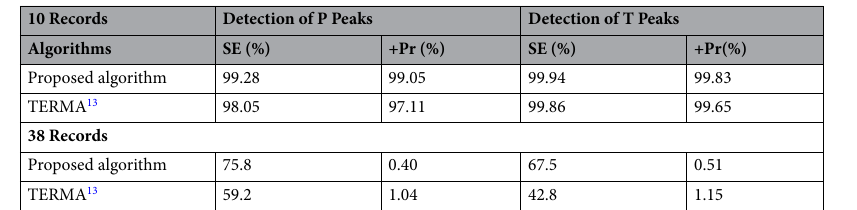
Table 2. Performance comparison of P and T-peak detection for the first 10 and remaining 38 records of the MIT-BIH database.